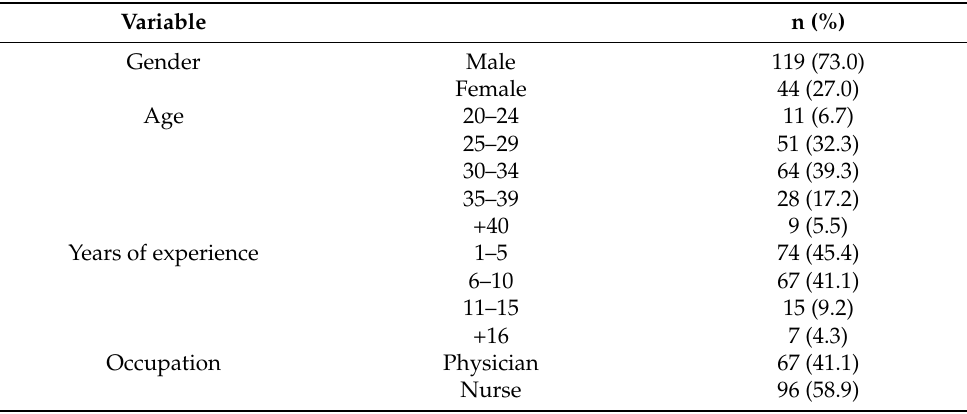
Table 1. Sociodemographic characteristics of included